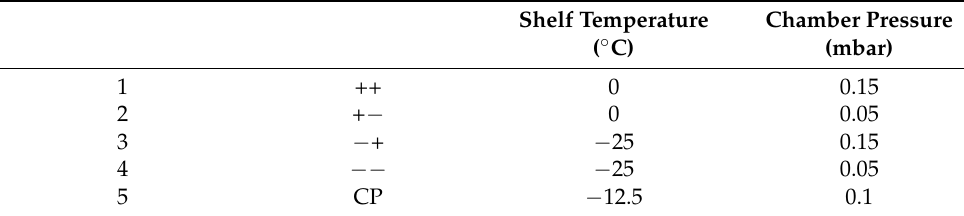
Table 2. Process parameters for K v